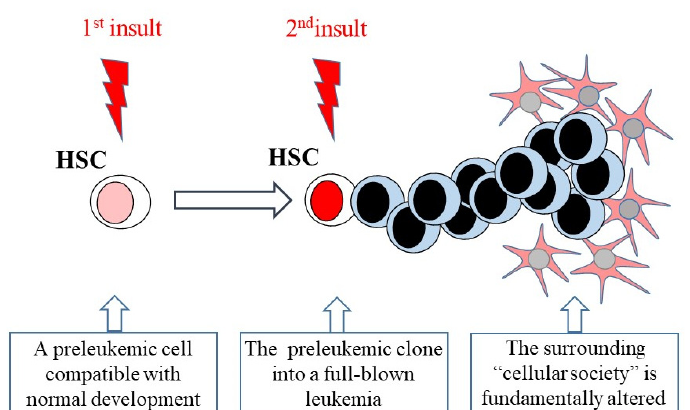
Figure 3. The genesis of the pathology of leukemia. The preleukemic cell that arises from the 1st insult is compatible with normal development. It is transformed into a leukemic clone by the second insult. This clone gives rise to a full-blown leukemia. The LSCs and/or their progeny fundamentally alter their surrounding “cellular society”.